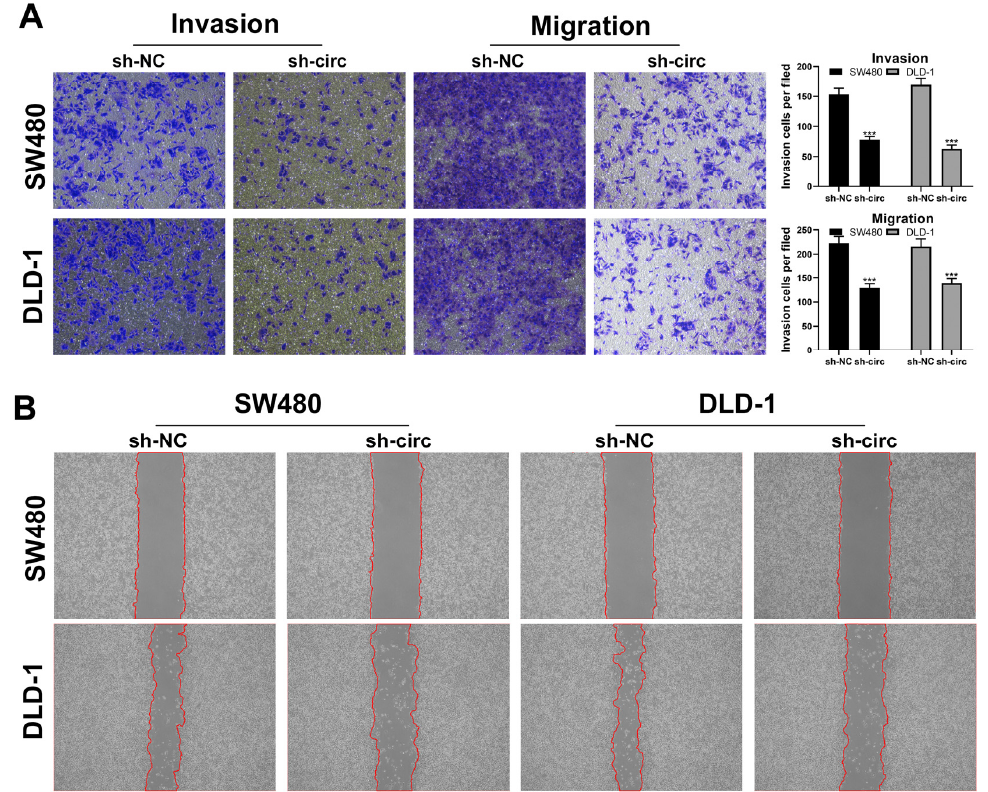
Figure 3. Hsa_circ_0008234 facilitates colon cancer invasion and migration. Notes: ( A ) Transwell assay between hsa_circ_0008234 knockdown and control cells, *** = p < 0.001; and ( B ) Wound healing assay between hsa_circ_0008234 knockdown and control cells.